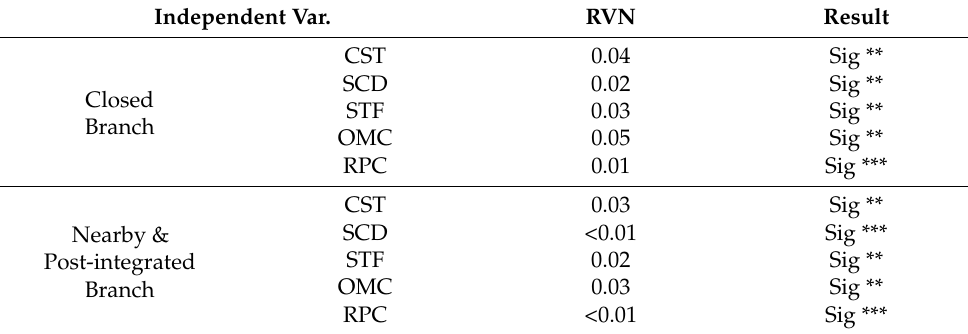
Table 14. Granger causality test. Independent Var. RVN